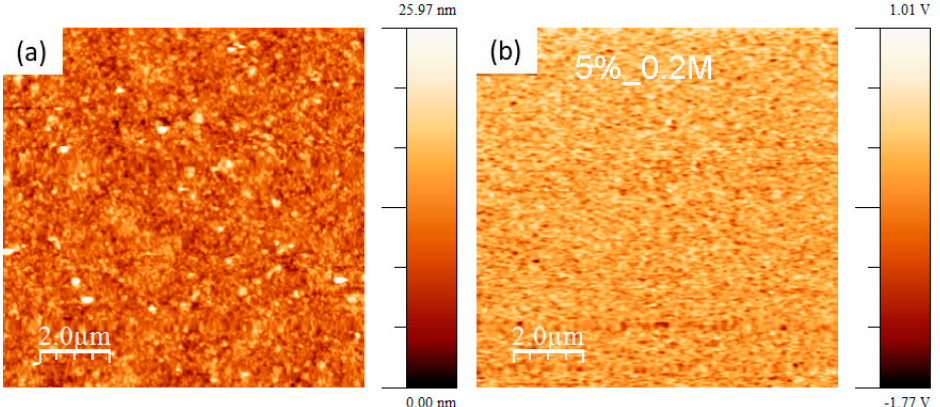
Figure 6. Topography ( a ) and out-of-plane piezo-force response image ( b ) of KNN thin films with 5% potassium excess and 0.2 M concentration deposited on platinized Al 2 O 3 .